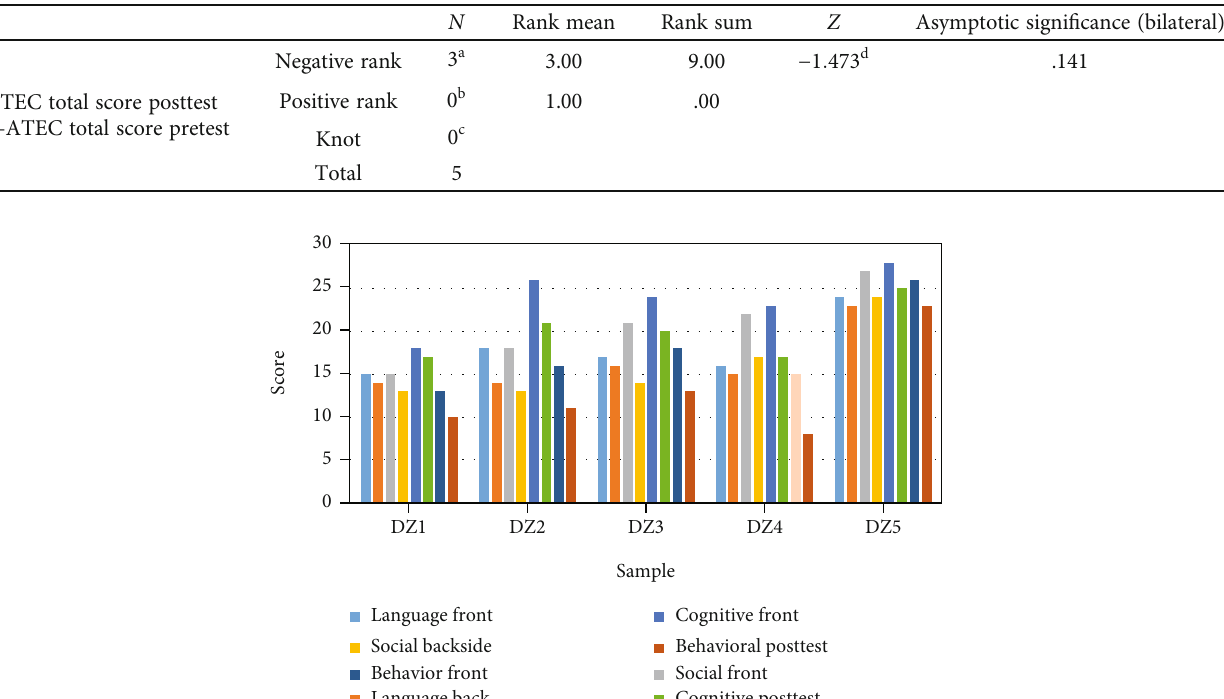
Figure 5: Visual chart of the scores of each subscale of ATEC before and after the fi ve children in the experimental